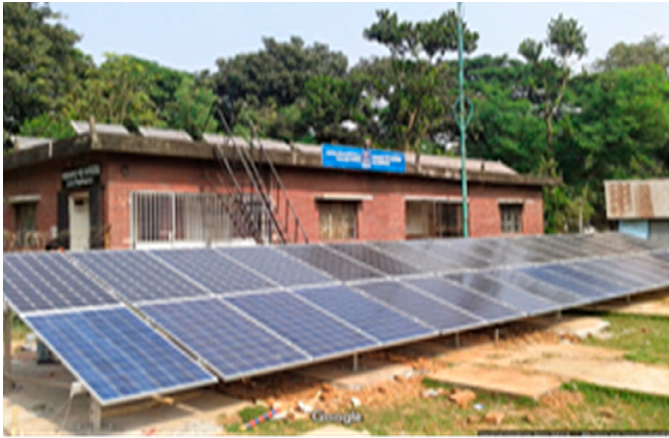
Figure 1. Solar PV panels in the University of Dhaka.